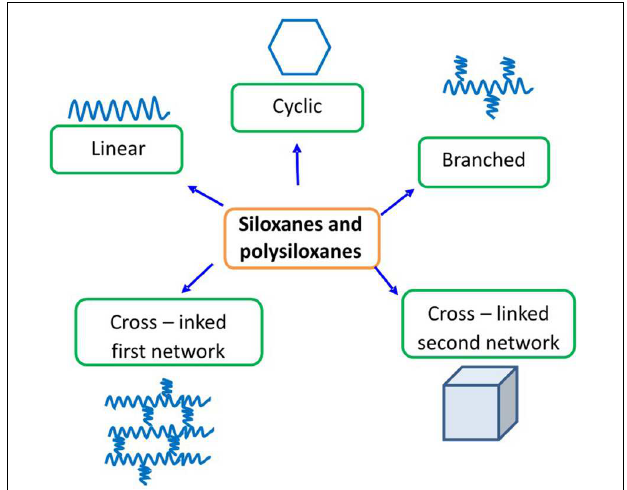
FIGURE 1 | Five basic structures of